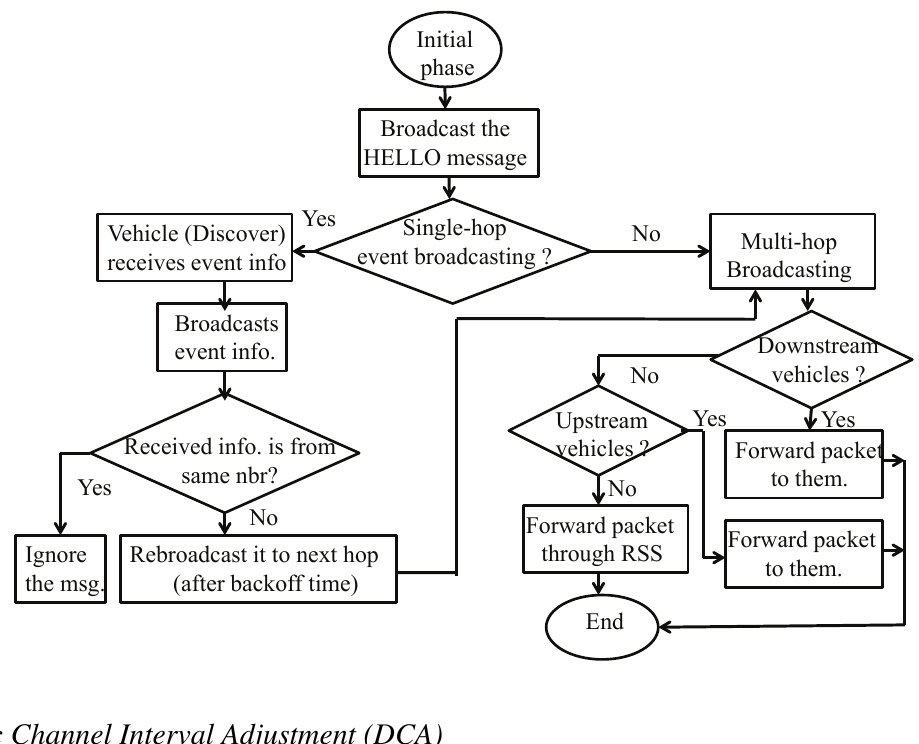
Figure 7. Flow chart for data transmission protocol in